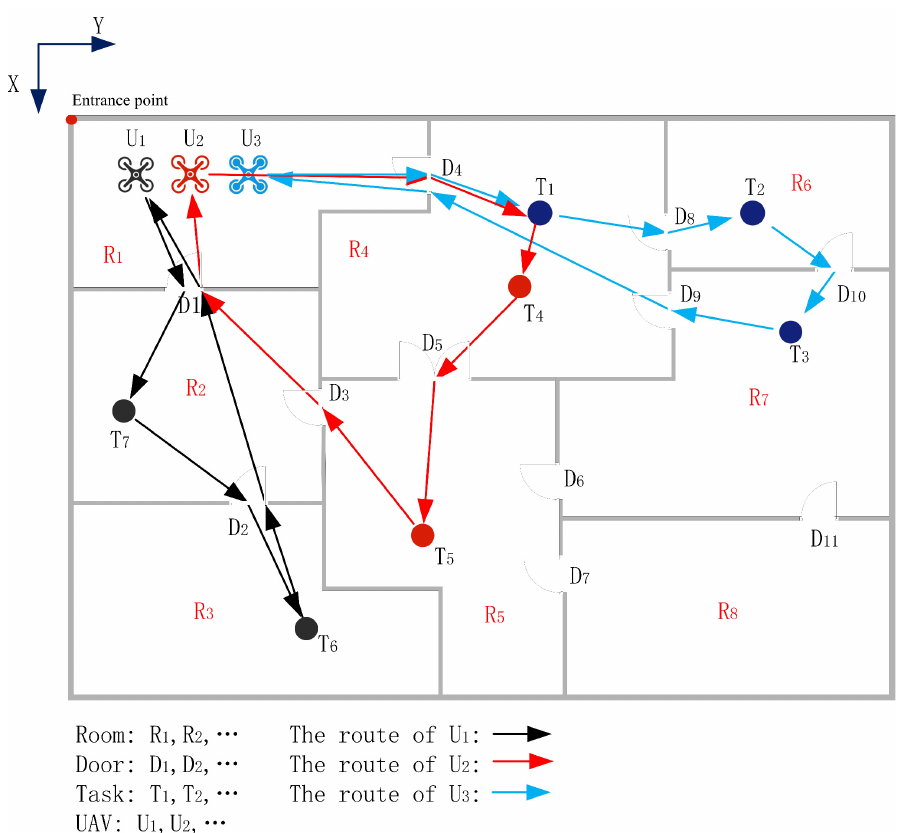
Figure 1. An example of three UAVs performing seven reconnaissance tasks in an indoor environment. Due to ability restrictions, a variety of task assignment situations could occur. One UAV performs one reconnaissance task, one UAV performs multiple reconnaissance tasks, or multiple UAVs perform one reconnaissance